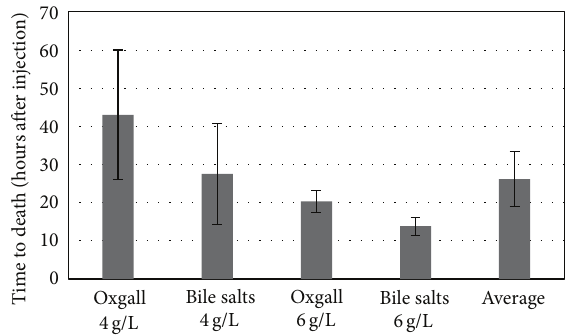
Figure 1: Acanthaster planci. Timeto death after injections of